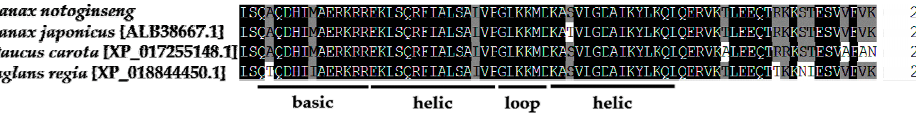
Figure 2. Alignment of deduced amino acid sequences of PnbHLH1 with the proteins of other plants bHLH. The domain of the bHLH class transcription factor was signed with horizontal lines (gray shading indicates the identity level > 75%, black shading indicates the identity level = 100%).